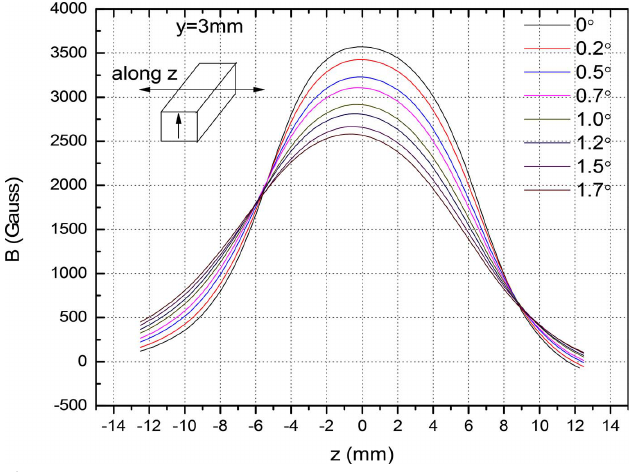
Figure 14 Effect of the angular tilt on the vertical field.